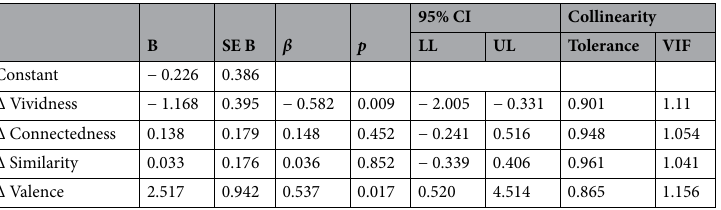
Table 2. Regression model predicting change in self-defeating behavior from T1 to T3. CI confidence interval, LL lower limit, UL upper limit.